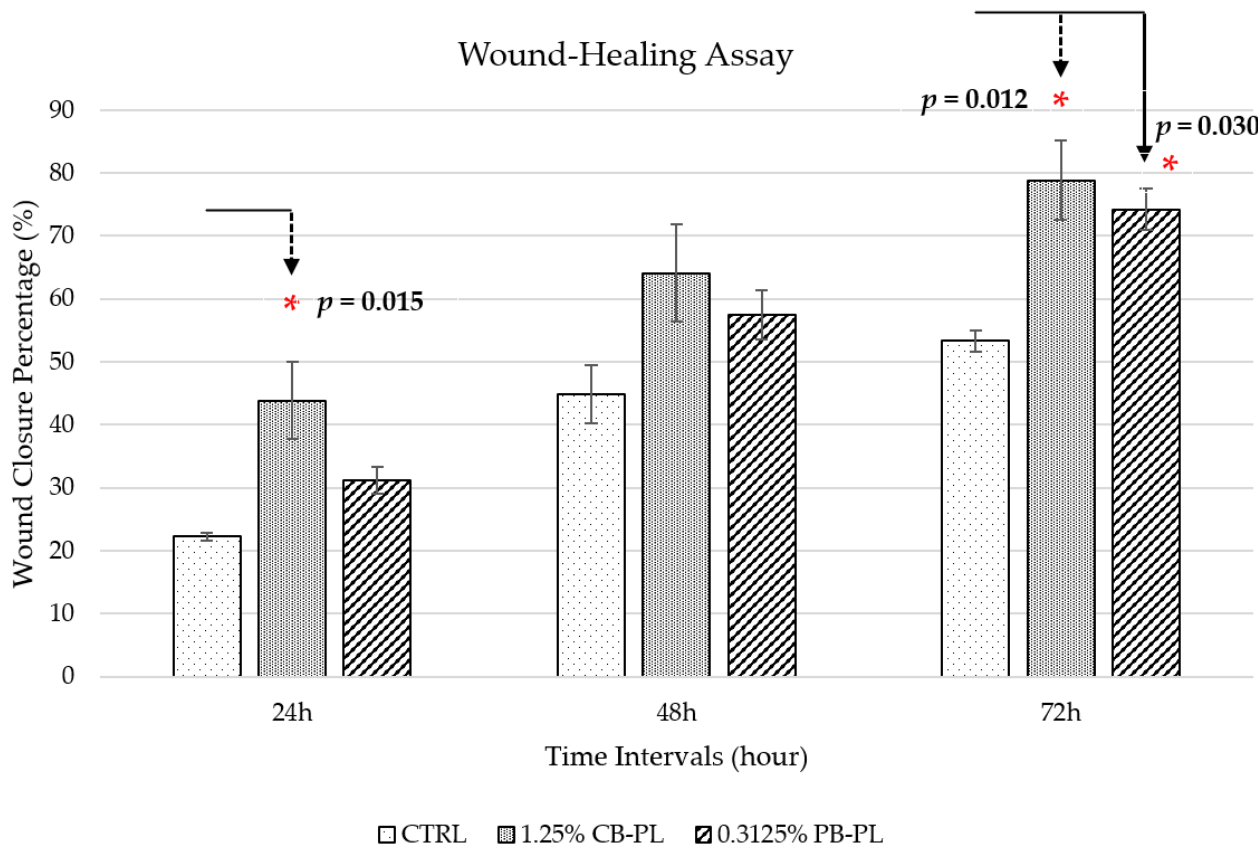
Figure 2. Wound-healing percentage of CTRL, 1.25% CB-PL and 0.3125% PB-PL towards the migration of HOMF. The wound closure was assessed after 24, 48 and 72 h of exposure to culture medium. All data were representative of three independent tests with n = 3 by groups and means ± SEM. * p < 0.05 denoted the statistical significance of 1.25% CB-PL and 0.3125% PB-PL when compared to CTRL.